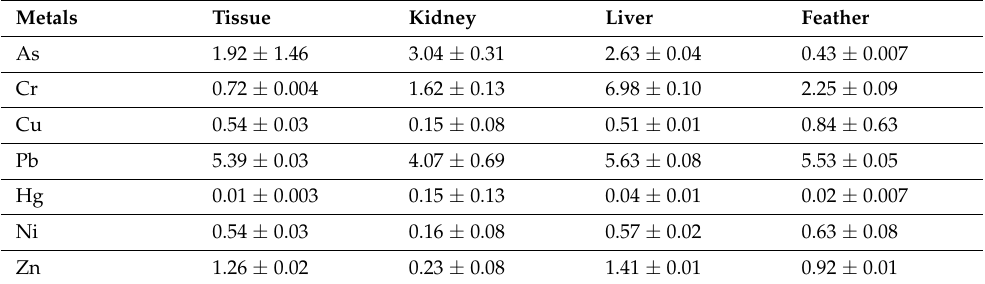
Table 2. Level of metals in the different organs of the black-crowned night heron, Veeranam Lake, Cuddalore, District, Tamil Nadu [Values are mean and SE; ppm (N = 3)].